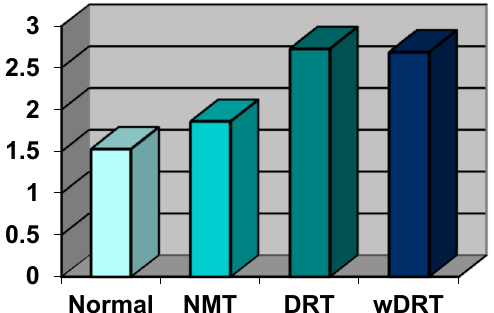
Figure 3. The value of the ROS species in all four groups of RP patients selected on the basis of OCT scans; data were expressed in mmol/L of the value of H 2 O 2 . The value in the Normal Group was chosen as the reference.